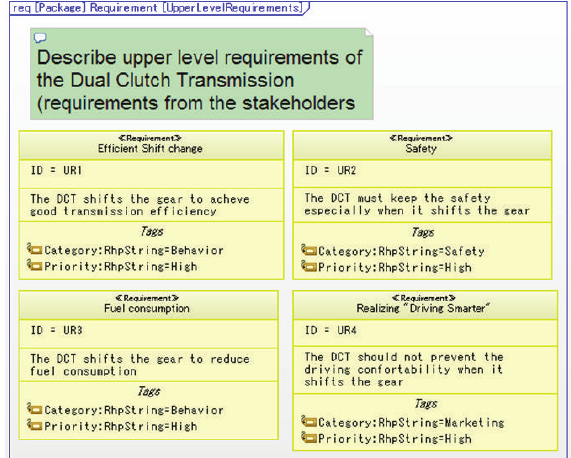
Figure 8: Upper level